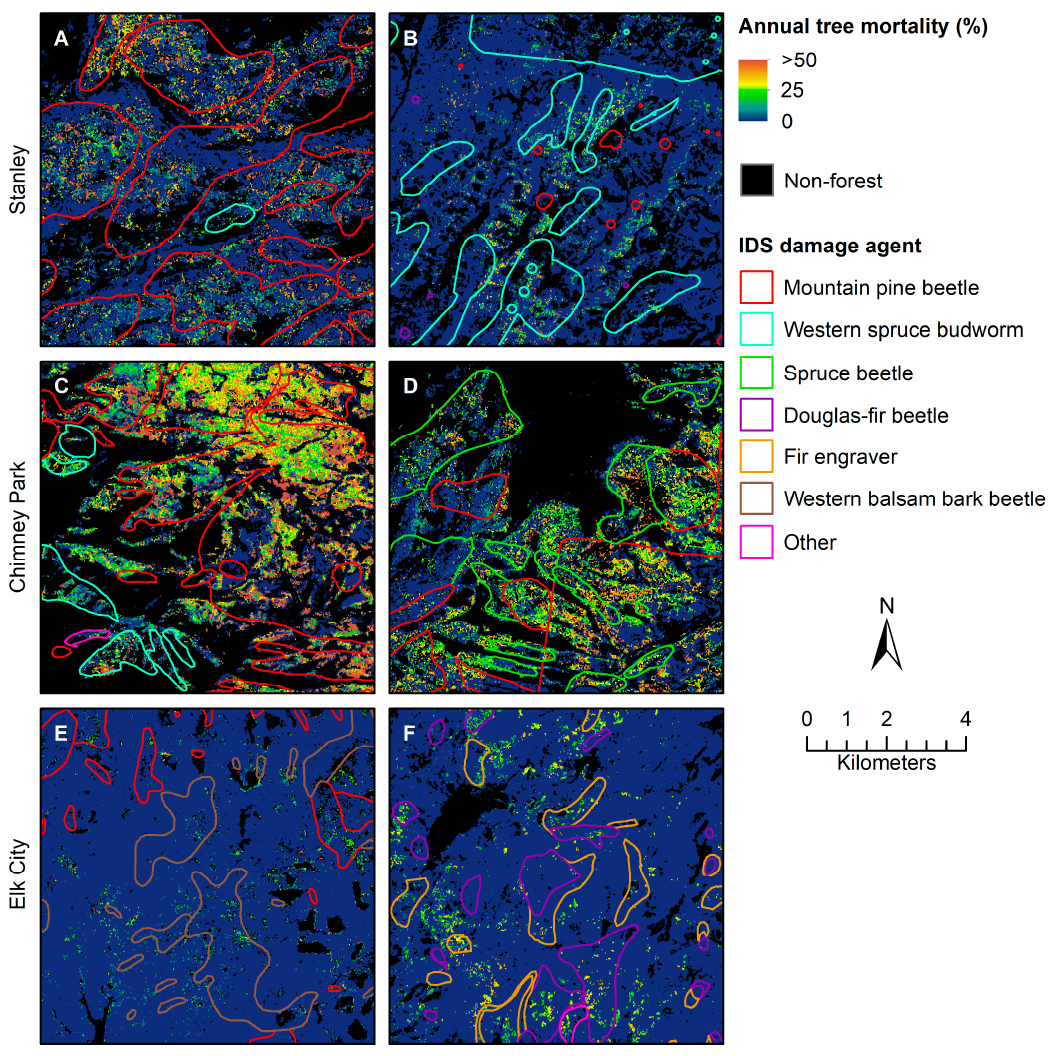
Figure 7. Comparison of annual maps of Landsat-derived percent tree mortality and insect and disease survey (IDS) polygon data from various insect agents. Panels show: ( A ) moderate forest mortality caused by mountain pine beetles in the Stanley study area in 2008; ( B ) low forest mortality caused by Western spruce budworms in the Stanley study area in 2015; ( C ) severe forest mortality caused by mountain pine beetles and Western spruce budworms in the Chimney Park study area in 2008; ( D ) moderate forest mortality caused by spruce and mountain pine beetles in the Chimney Park study area in 2011; ( E ) low forest mortality caused by Western balsam bark and mountain pine beetles in the Elk City study area in 2001; and ( F ) low forest mortality caused by Douglas-fir and fir engraver beetles in the Elk City study area in 2017.